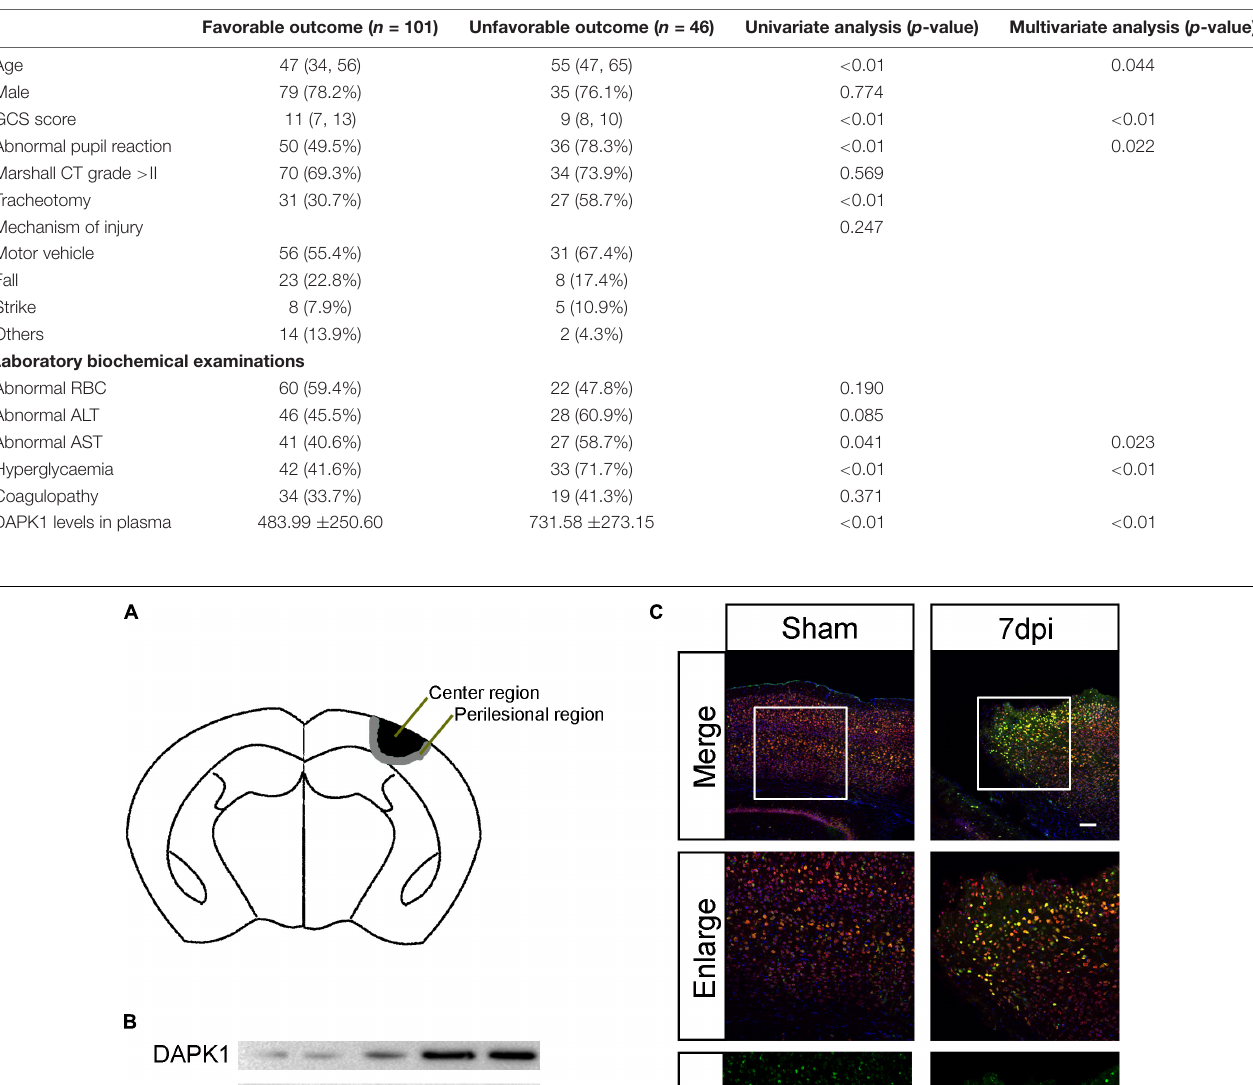
TABLE 1 | Characteristics of the study population.